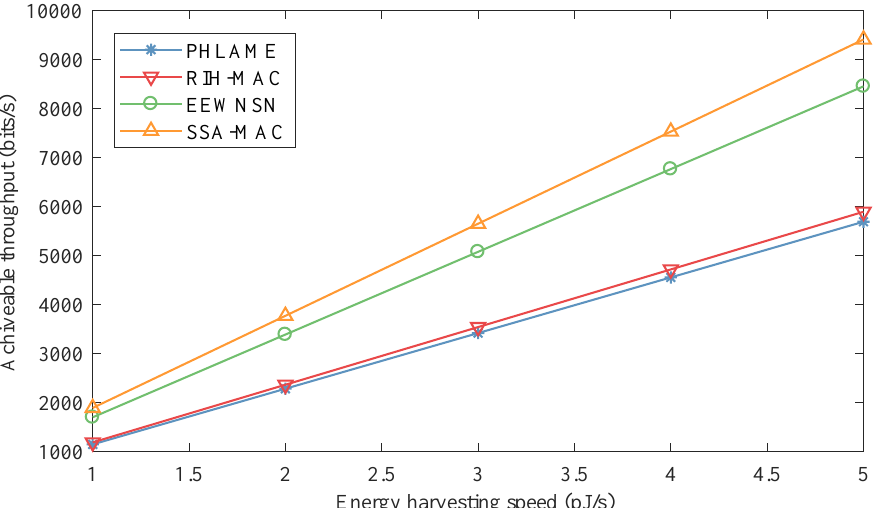
Figure 10. Achievable throughput of different MAC protocols as a function of energy harvesting speed in centralized